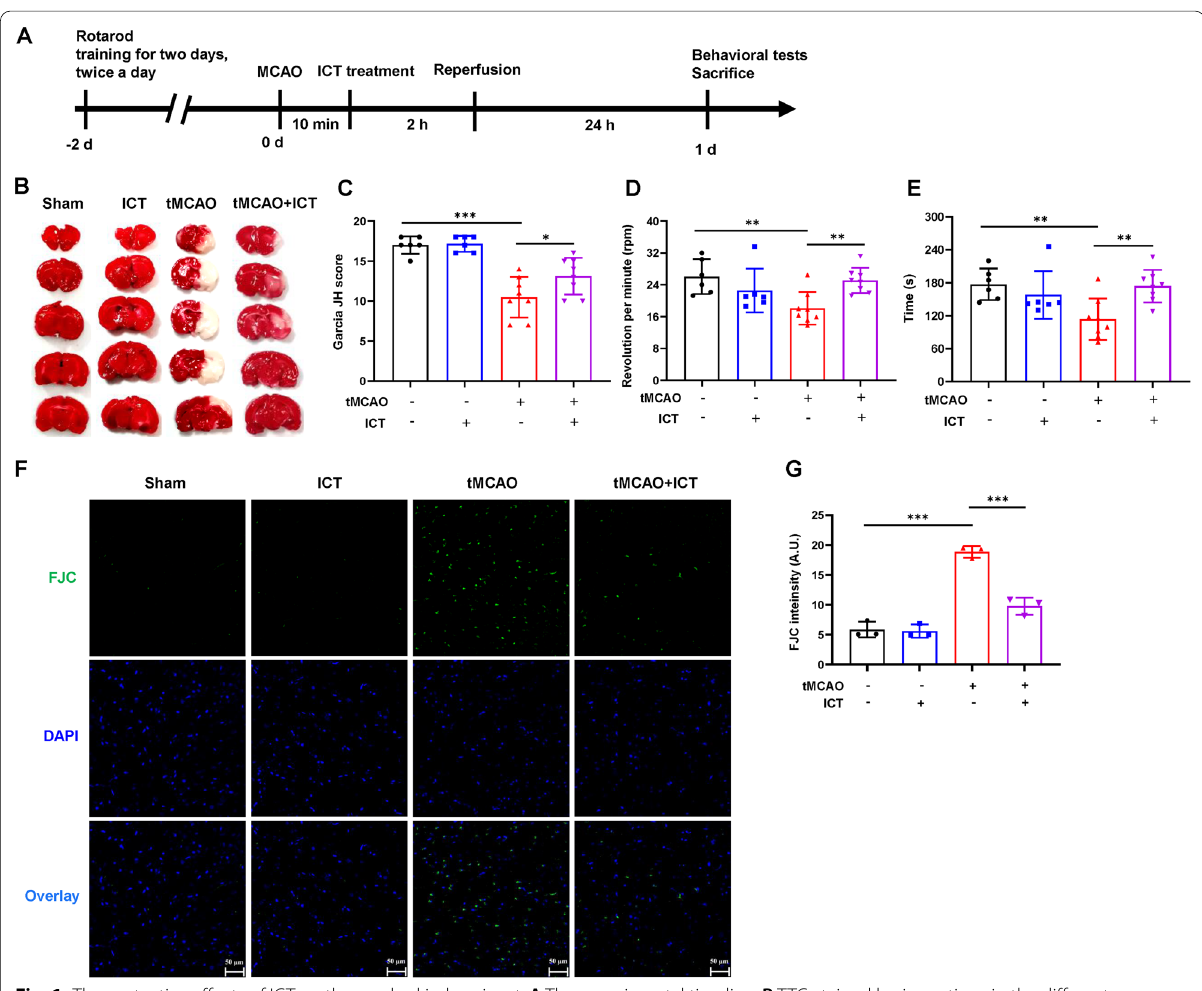
Fig. 1 The protective effects of ICT on the cerebral ischemia rat. A The experimental timeline. B TTC-stained brain sections in the different groups. C Neurological function scores (n 6–8). D The rotating speed in rotarod test. E The time on rod in rotarod test (n = neurons were measured by FJC staining. Green fluorescence showed degenerating neurons, and blue fluorescence represented DAPI (n bar 50 μm. The results are expressed as the mean SD, * P < 0.05, *** P < = ±